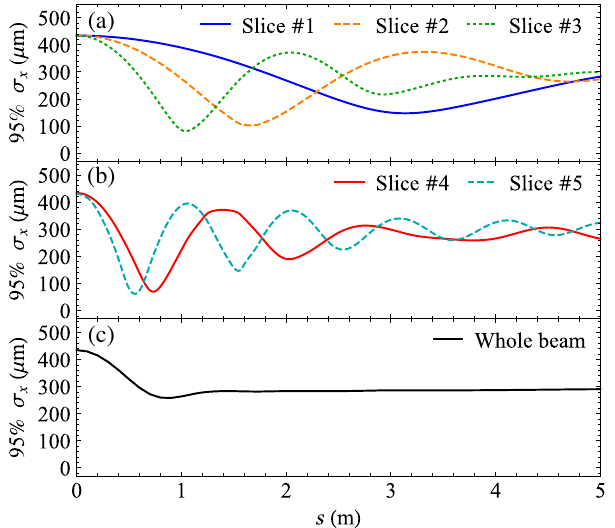
FIG. 9. Variation of horizontal rms beam sizes along the DWA structure. Initial beam size is σ x 0 ¼ 500 μ m but 5% of particles with largest deviation from the axis are discounted. The beam is set on axis. Vertical wakefields F y are removed. (a, b) five slices as shown in Fig. 8. (c) projected size of the whole beam.